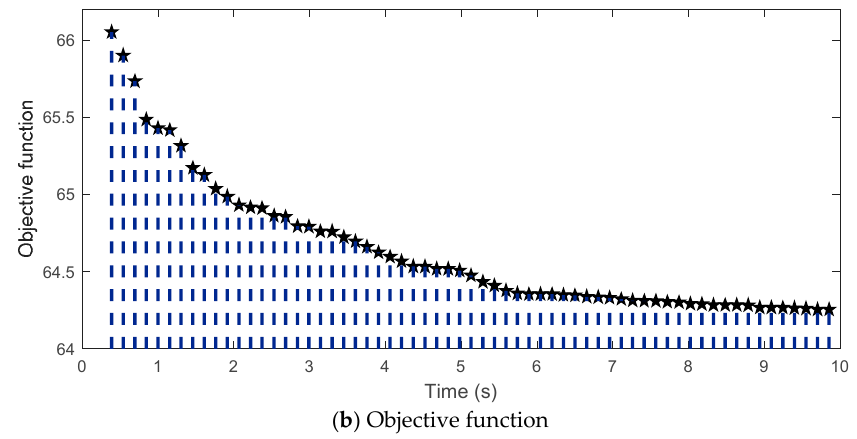
Figure 6. Convergence of the seventh source task of the IEEE 118-bus system obtained in the pre-learning process.